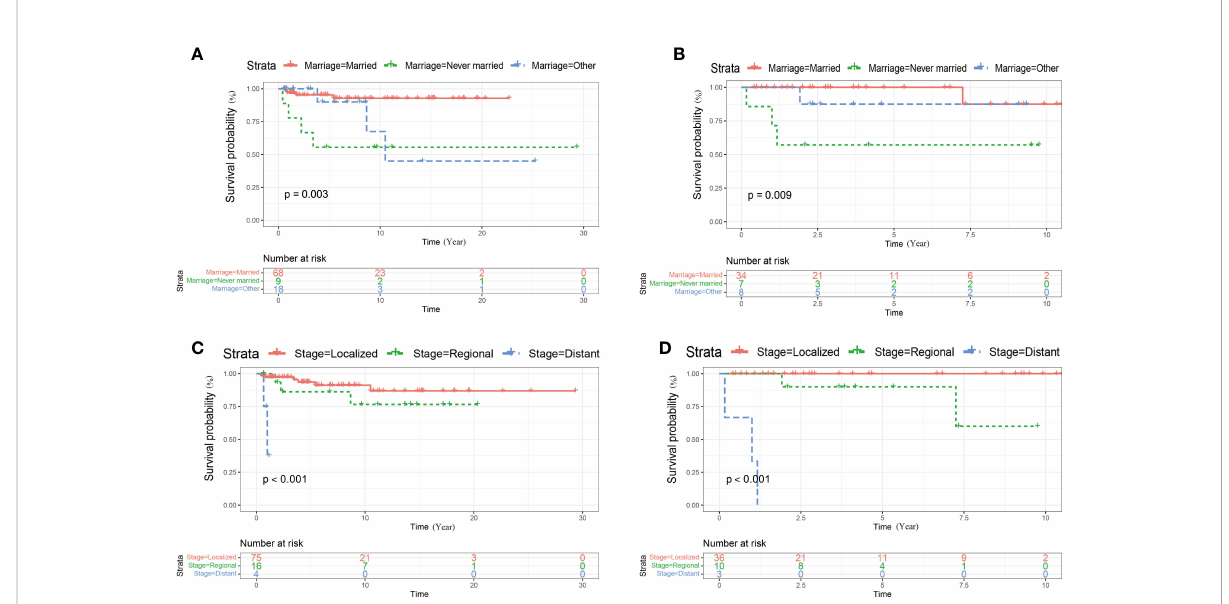
FIGURE 2 Kaplan – Meier curves of CSS for patients with penoscrotal EMPD strati fi ed by marital status (A, B) and SEER historic stage A (C, D) in thetraining cohort and validation cohort